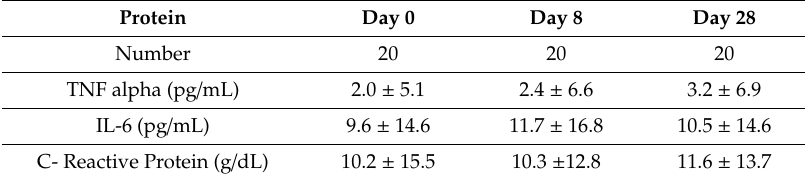
Table 4. Serum Indicators of Inflammation and Injury.